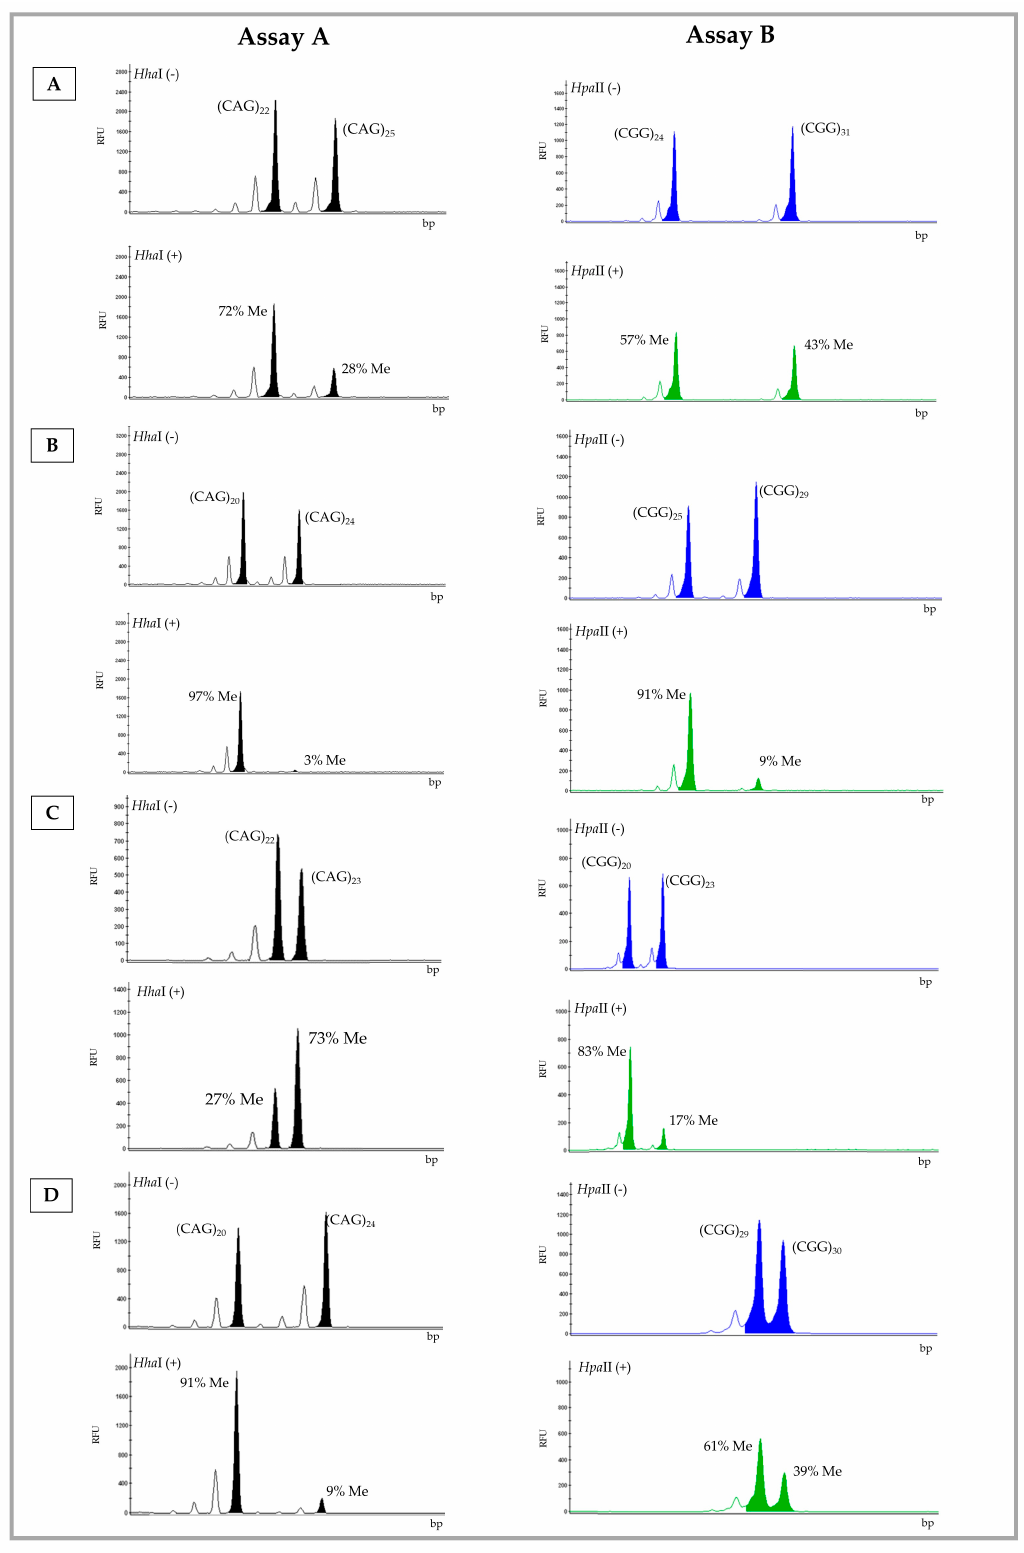
Figure 1. Electropherogram of the A and B Assay results for samples number 29 ( A ), 37 ( B ), 39 ( C ), and 45 ( D ). Digested allele (+) and undigested allele ( − ). Number of CAG ( AR ) and CGG ( FMR1 ) repeats and respective percentage of methylation (Me). Blue (FAM-labelled)—undigested allele; green (HEX-labelled)—digested allele; RFU—relative fluorescence Units; bp—base